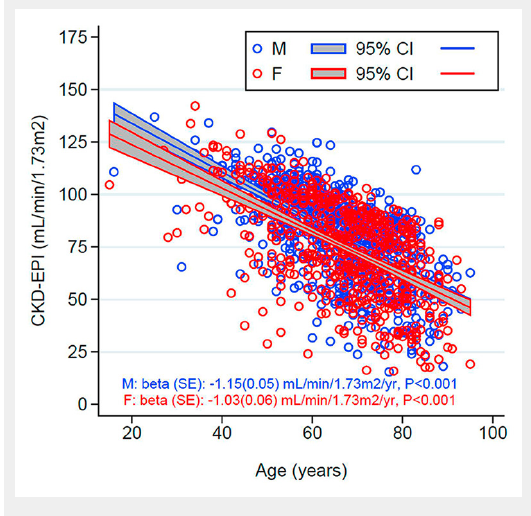
Beta coefficient and standard error (SE) from simple linear regression.